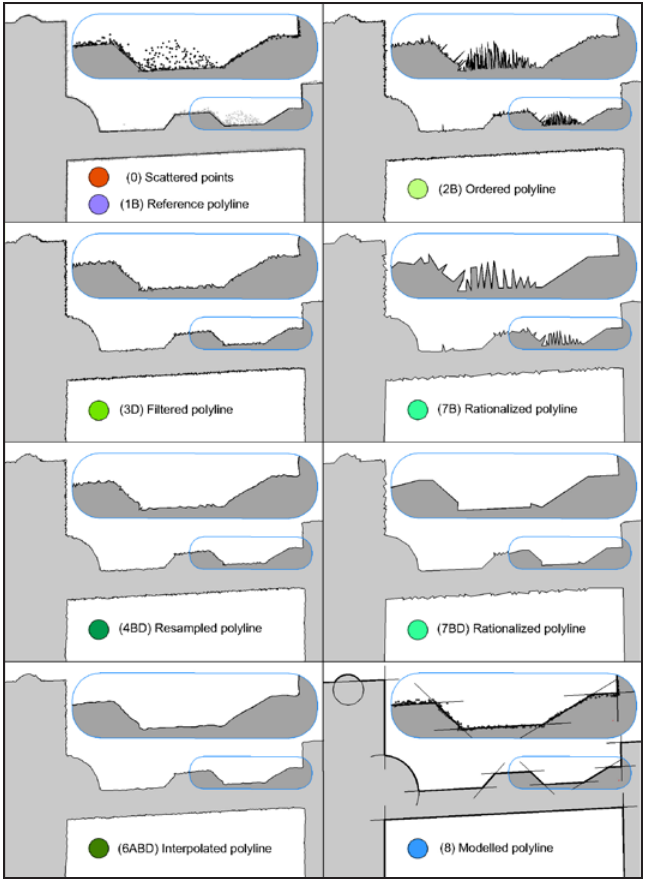
Fig. 4 Anzani, G., V iew of some of the products related to the chosen application case and resulting from the application of specific processes (related data in Table 2) ,